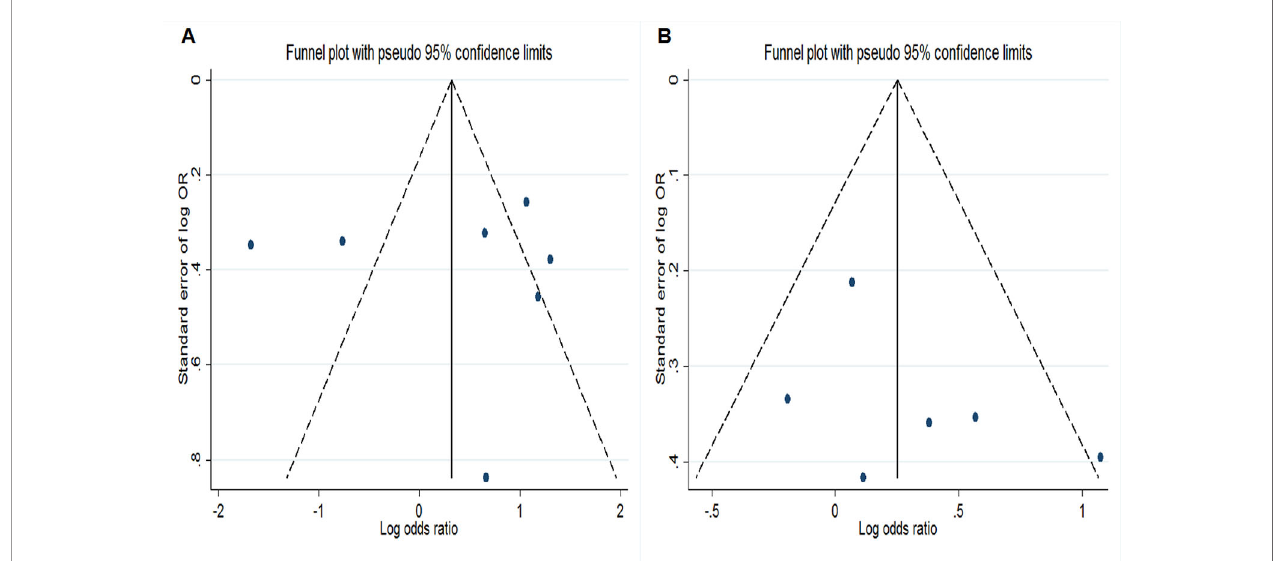
FIGURE 4 | Funnel plots for evaluation of publication bias. (A) Funnel plot of meta-analysis evaluating rs1800470 and chronic kidney disease susceptibility under dominant model. (B) Funnel plot of meta-analysis evaluating rs1800471 and chronic kidney disease susceptibility under dominant